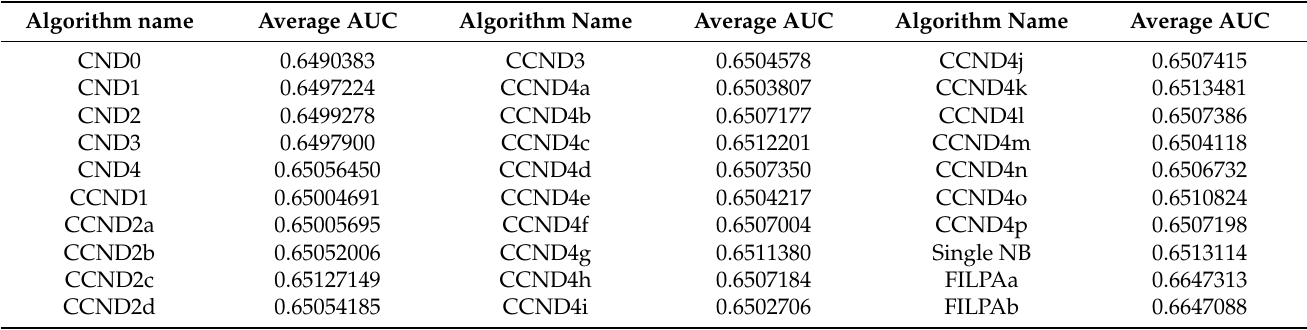
Table 4. The performance of all algorithms ( θ =